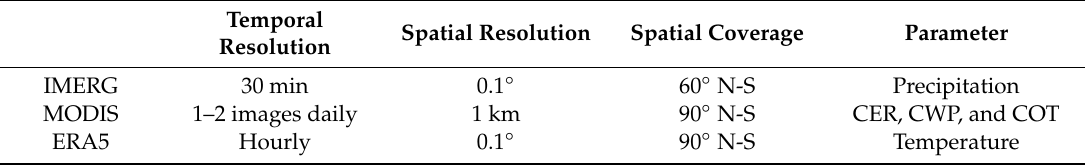
Table 1. Characteristics of data used in this